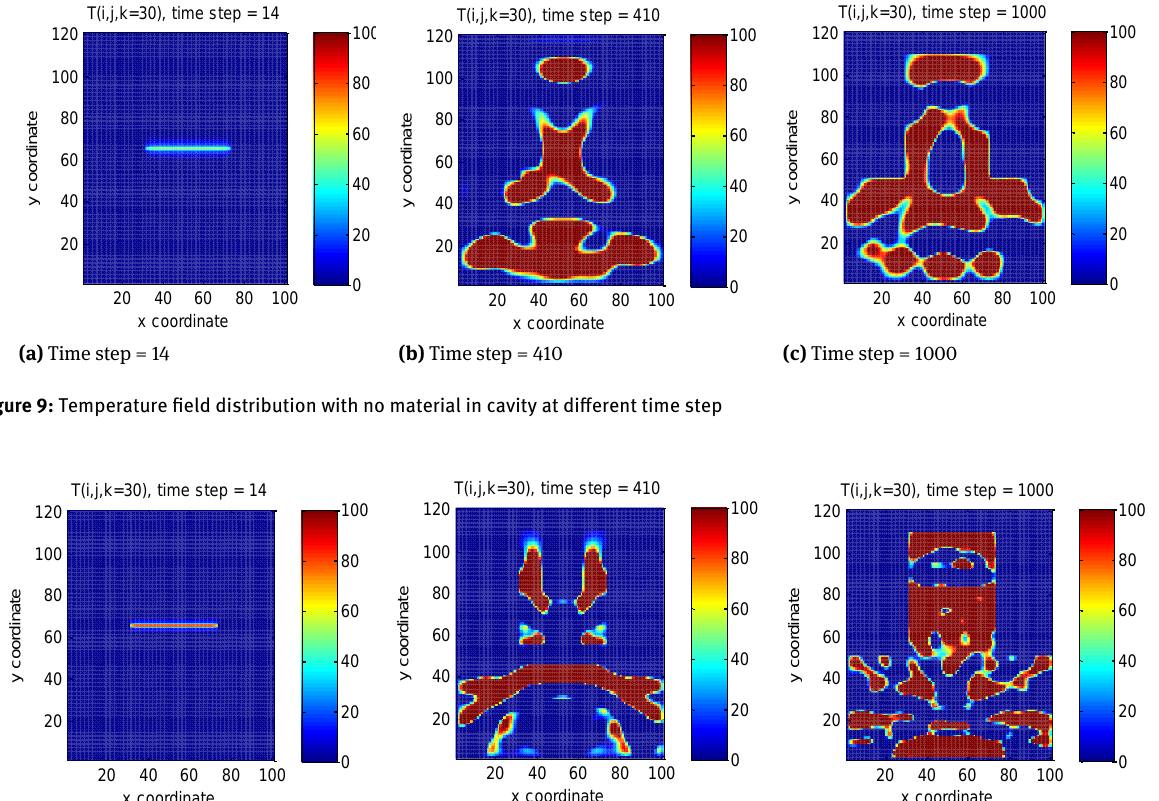
tion of electromagnetic waves will become very low effi- ciency when at a lower water content for sodium